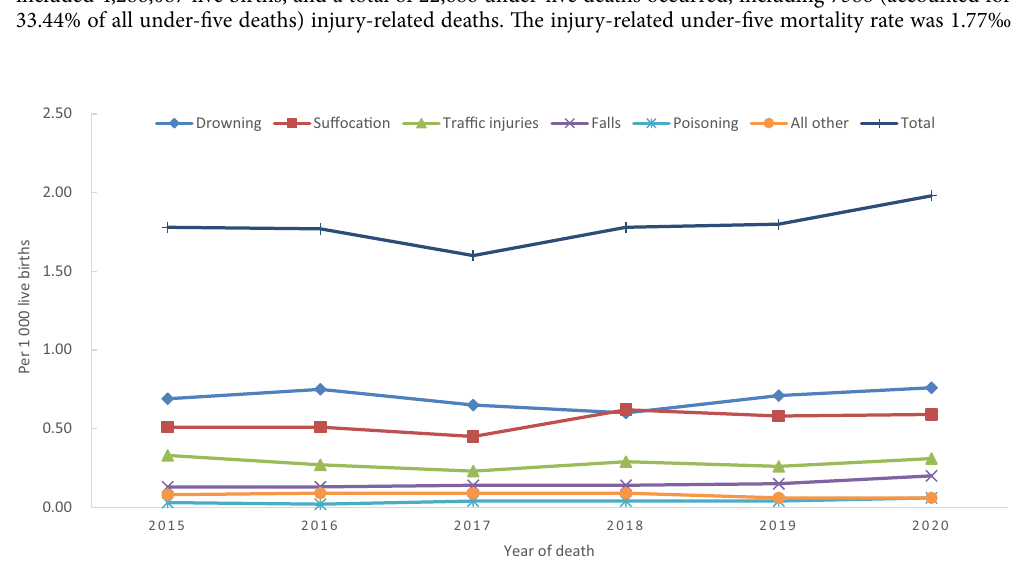
Figure 1. Time trends in injury-related under-five mortality rate in Hunan Province, China,